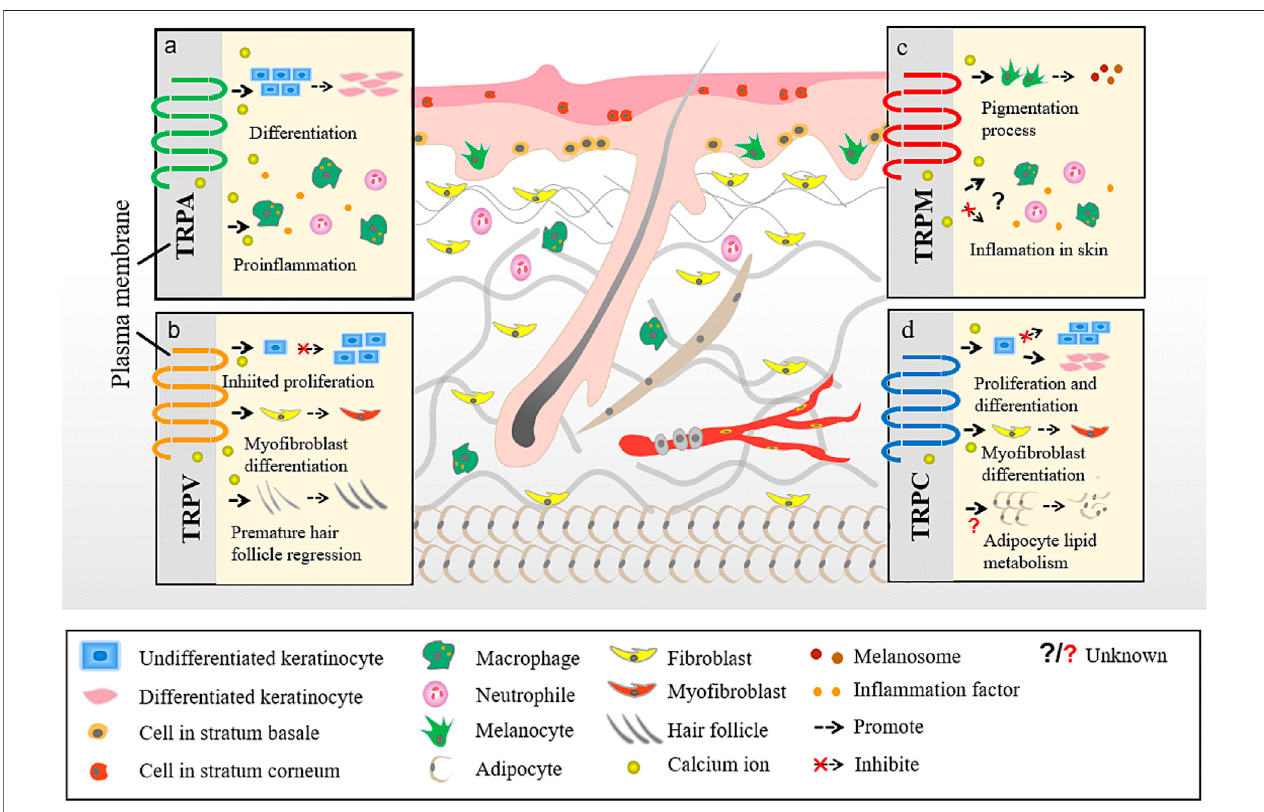
FIGURE 2 | Different TRP channels participate in different skin homoeostasis and barrier function. a. The interaction between TRPA and skin. b. The interaction between TRPV and skin. c. The interaction between TRPM and skin. d. The interaction between TRPC and skin.